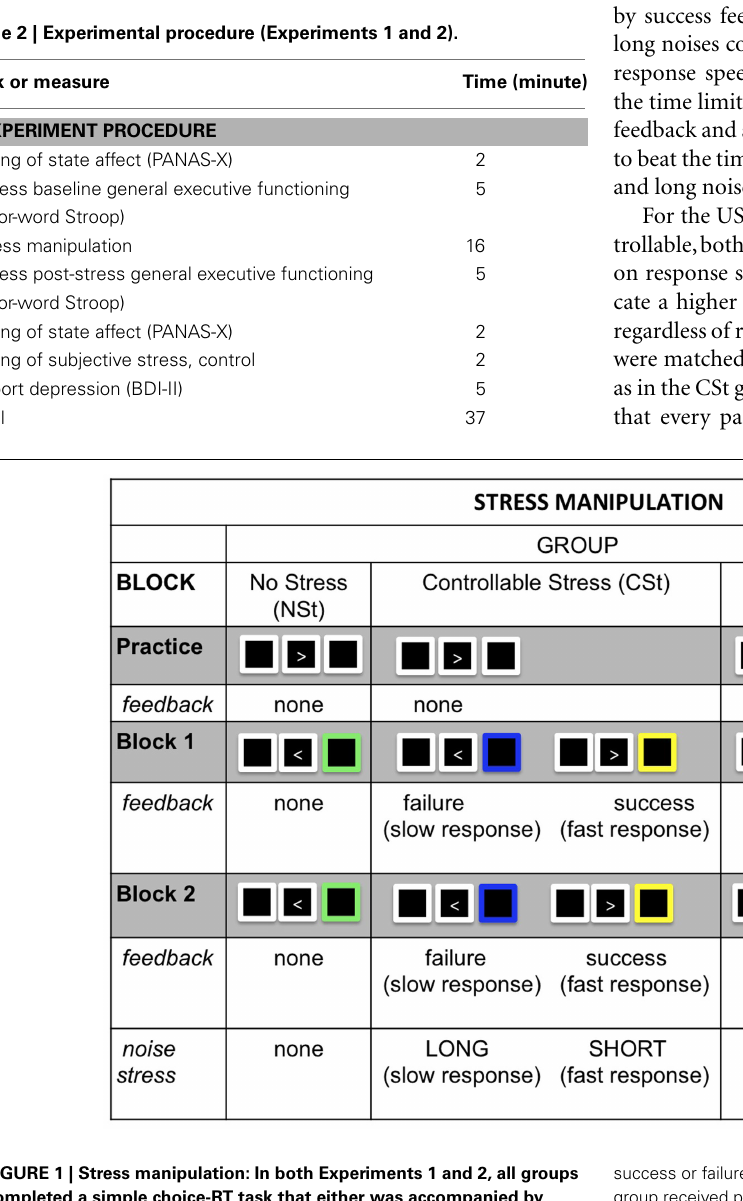
FIGURE 1 | Stress manipulation: In both Experiments 1 and 2, all groups completed a simple choice-RT task that either was accompanied by psychological stress in the form of performance feedback and noise exposure (controllable stress: CSt group and uncontrollable stress: USt group) or was not accompanied by these forms of stress (no-stress: NSt group). The manipulation consisted of a practice block that was